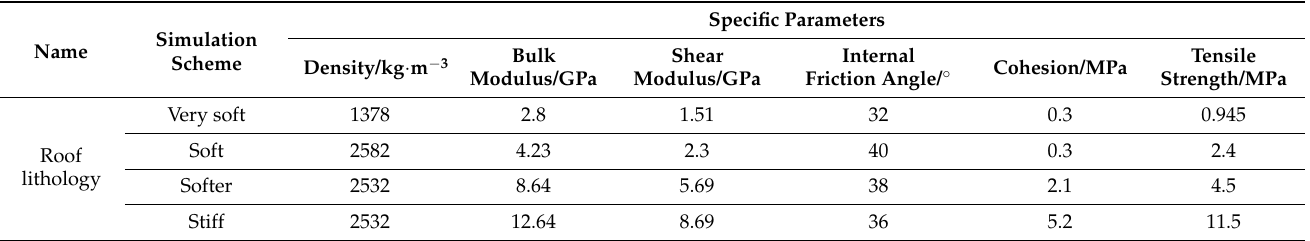
Table 2. Simulation scheme under different roof lithology